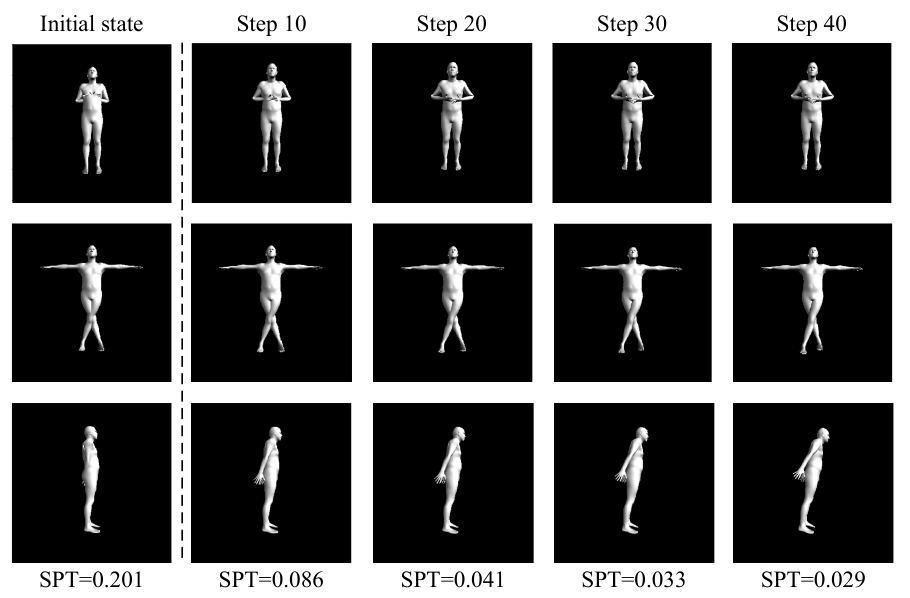
Figure 6. Images rendered from the iterative process. First column: Images rendered from initial meshes with self-intersection. Second through fourth columns: Images rendered from optimized meshes every 10 iterations. The self-intersection penalty term (SPT) values in the bottom of each column denote the average SPT of three SMPL